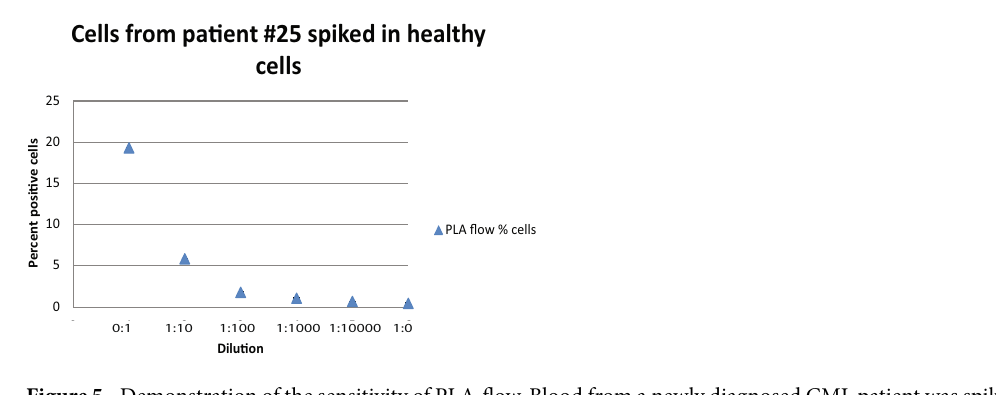
Figure 4. Long-term follow-up of newly diagnosed patients. Two CML patients were followed from the time of initial diagnosis, by measuring BCR-ABL1 positive cells using PLA-flow and BCR-ABL1 transcript levels using RQ-PCR, every 3 months over a period of 9 months. ( A and B ) Display results for patient 1 and 2, respectively, analyzed with PLA-flow (diamonds) and RQ-PCR (circles).